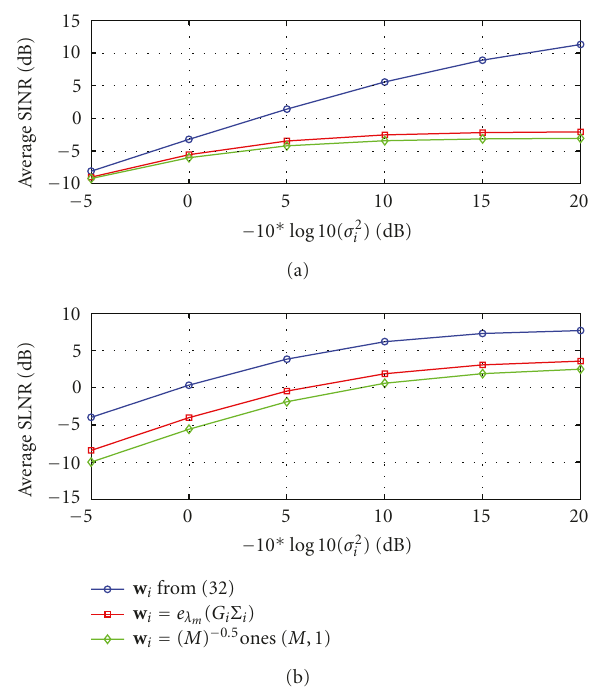
Figure 8: Average SINR and average SLNR versus noise power for the user i = 1 (Gaussian AoA model with σ θ = 3 ◦